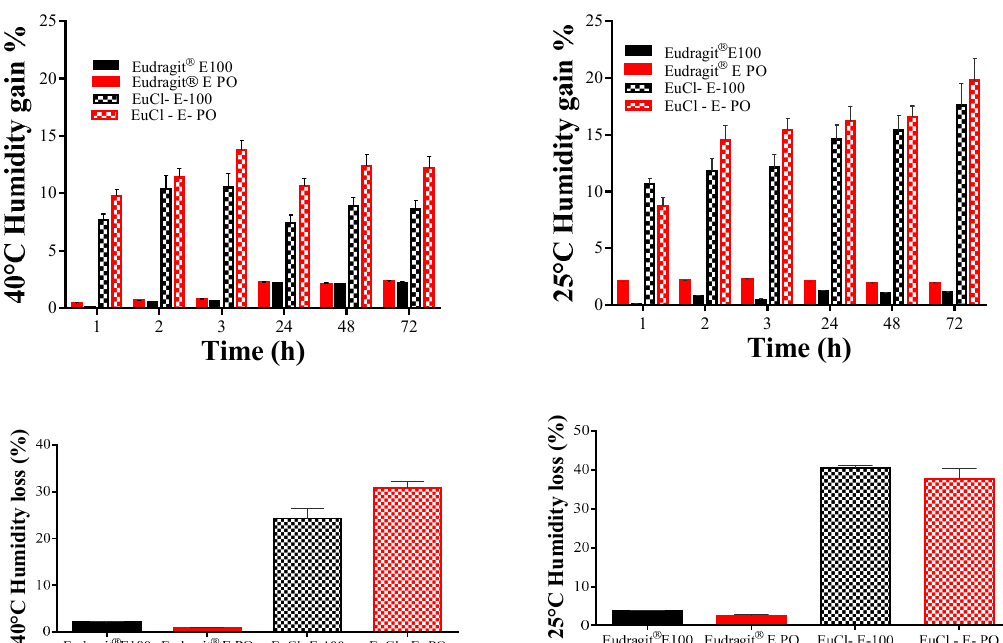
Figure 7. Loss and gain of humidity by polymers derived from Eudragit ® E.